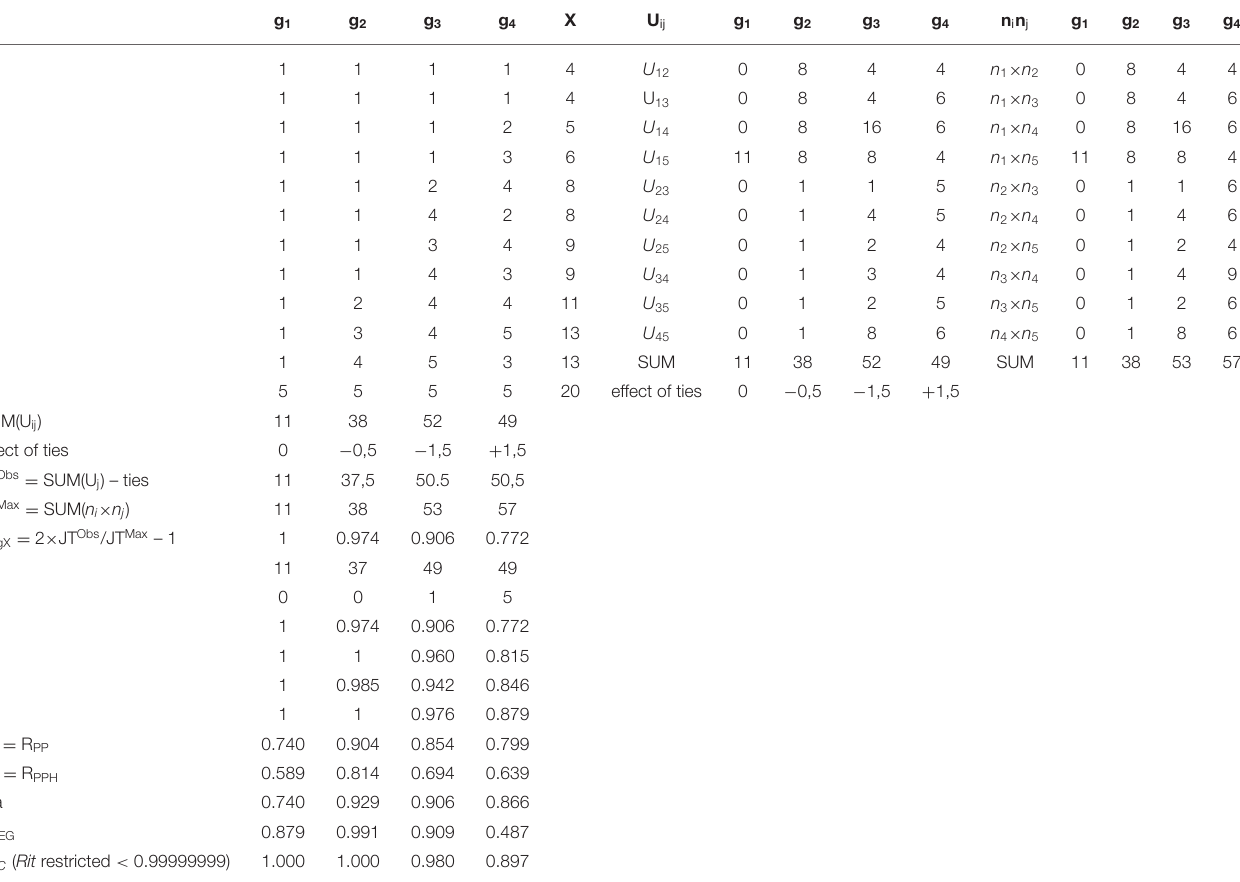
TABLE 2 | A hypothetic dataset to illustrate the computing of coefficients of rank–polyserial correlation.